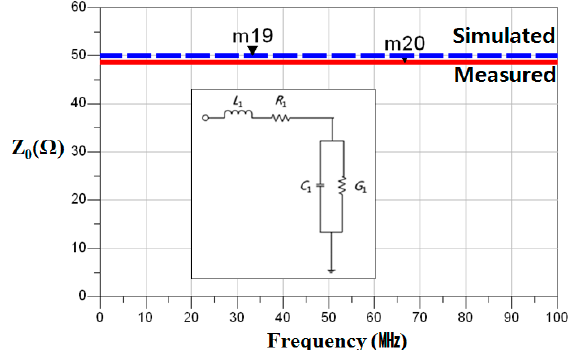
Figure 2. Z 0 and equivalent circuit of Cu filled TSV.